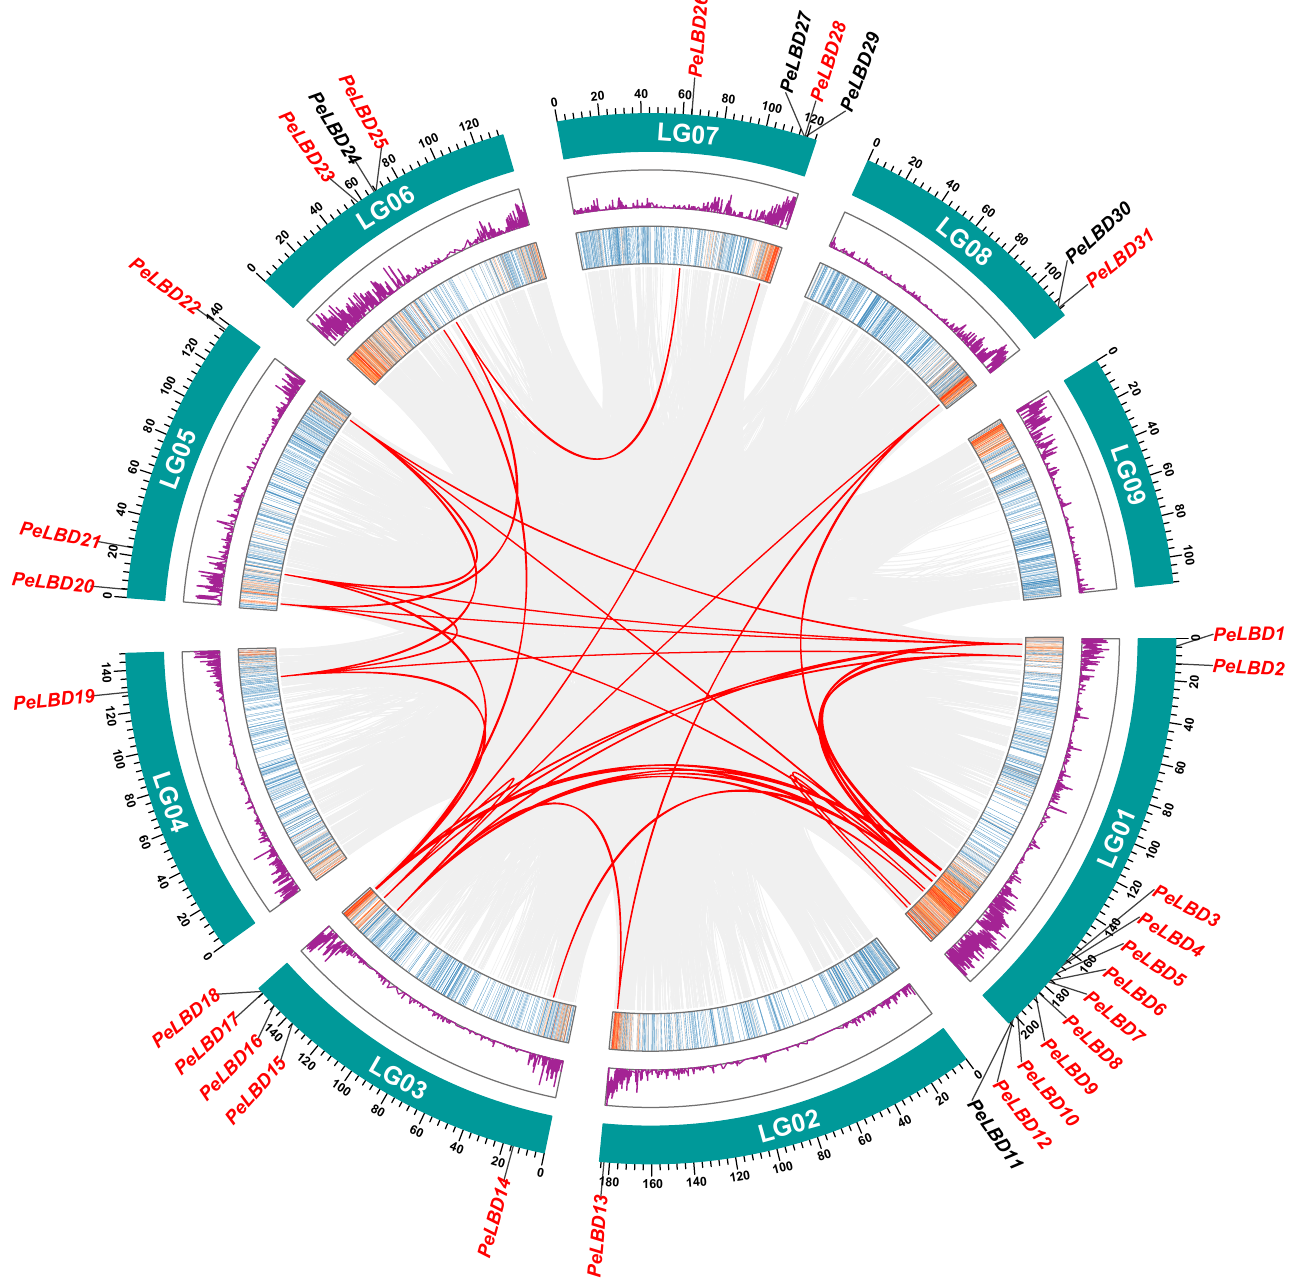
Figure 5. Distribution and collinearity of PeLBD gene family in passion fruit genome. PeLBDs marked in red have collinearity, while PeLBDs marked in black lack collinearity. The two rings in the middle represent the gene density of each chromosome. The gray background lines represent collinear backgrounds. The orange line represents the collinear relationship between PeLBD